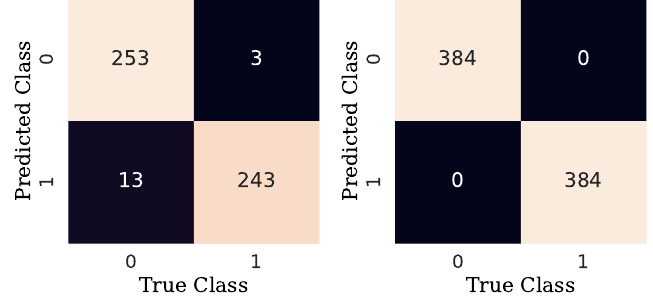
Figure 16. Confusion matrices for damage diagnosis models 1 ( left ) and 2 ( right ).